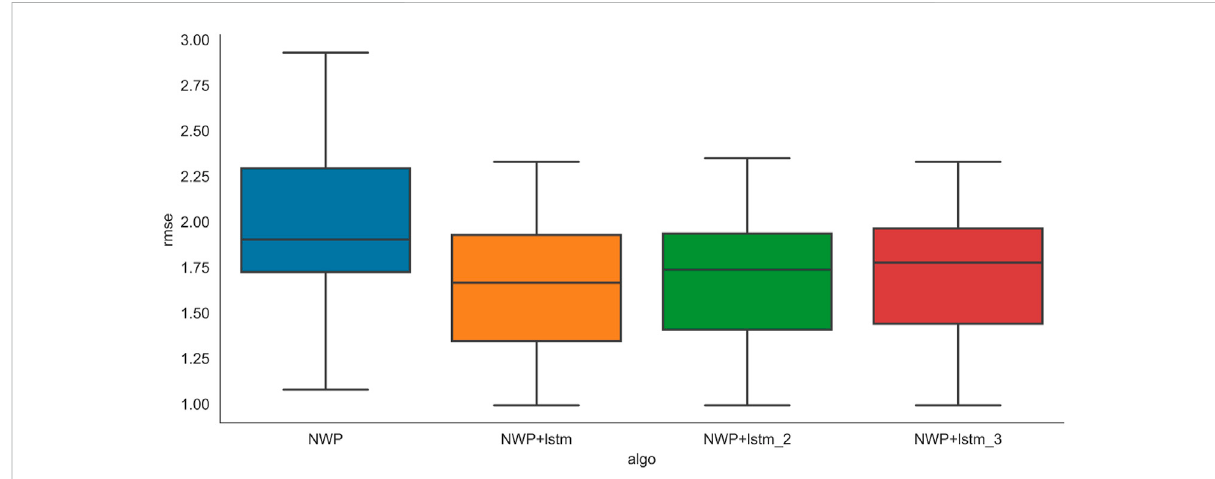
FIGURE 14 Overall rmse results for different prediction steps based on the location.